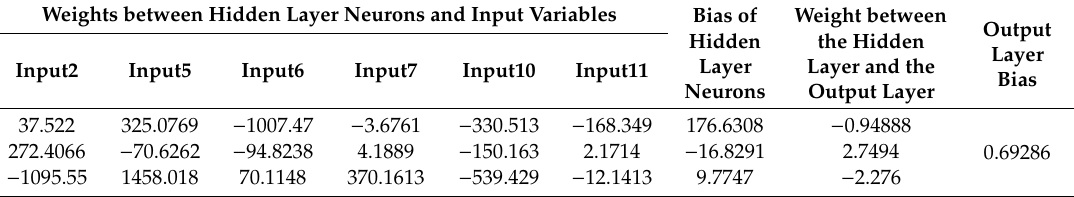
Table 9. Weight and bias coe ffi cients for the proposed MLP